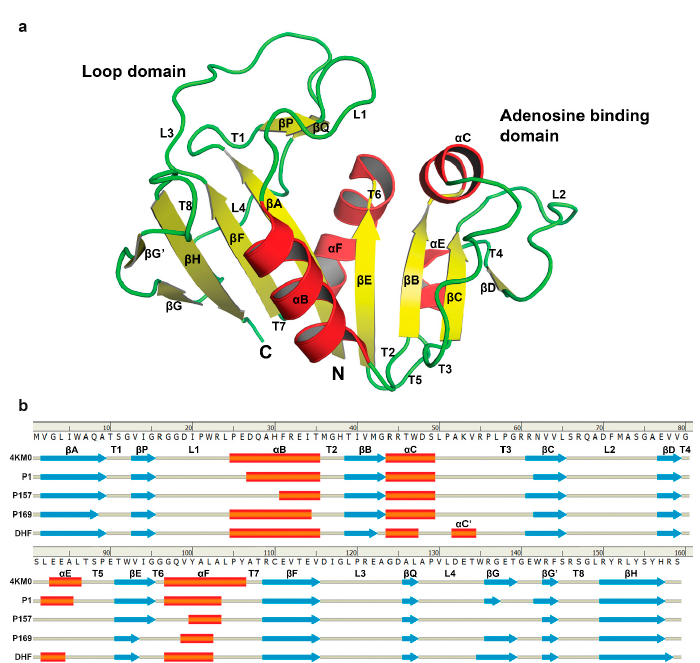
Figure 3. The schematic structure of mtbDHFR. ( a ) Structure of mtbDHFR. Coils in green, alpha-helices in red, and beta-strands in yellow; ( b ) Sequence and secondary structure of each MD simulation at 16 ns. The secondary structural elements are assigned according to the Define Secondary Structure of Proteins method (DSSP) by Discovery Studio Visualizer 4.0 program [14].